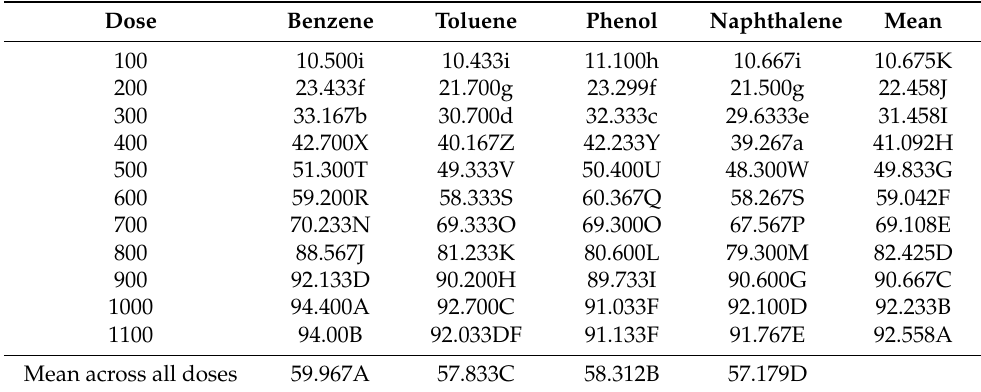
Table 7. Comparison test of TiO 2 /AC dose vs. reduction in pollutant